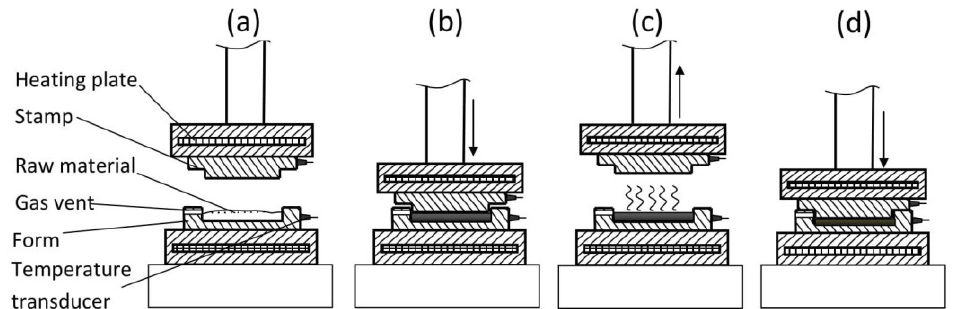
Figure 1. Biocomposite production process: ( a ) material load, ( b ) initial pressing, 5 MPa during 30 s, ( c ) evaporation of water, 10 s, ( d ) main pressing, 20 MPa, time 5.5 min.